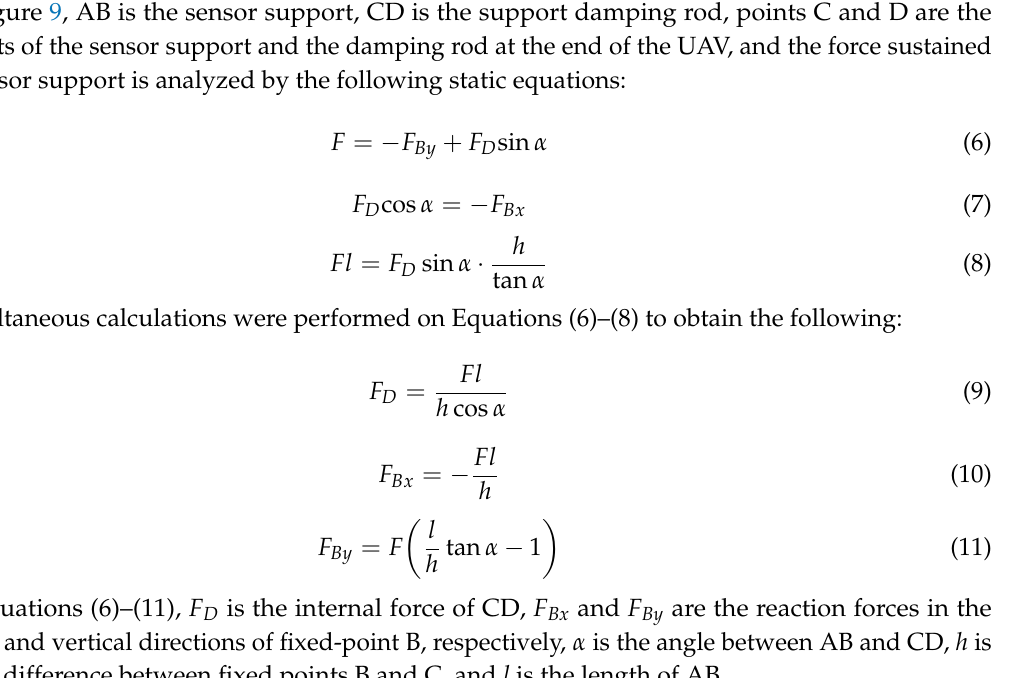
Figure 9. Analysis of the force sustained by UAV sensor support. ( a ) Schematic diagram of the structure of the support and damping rod; ( b ) analysis of the force sustained by each part of the support.